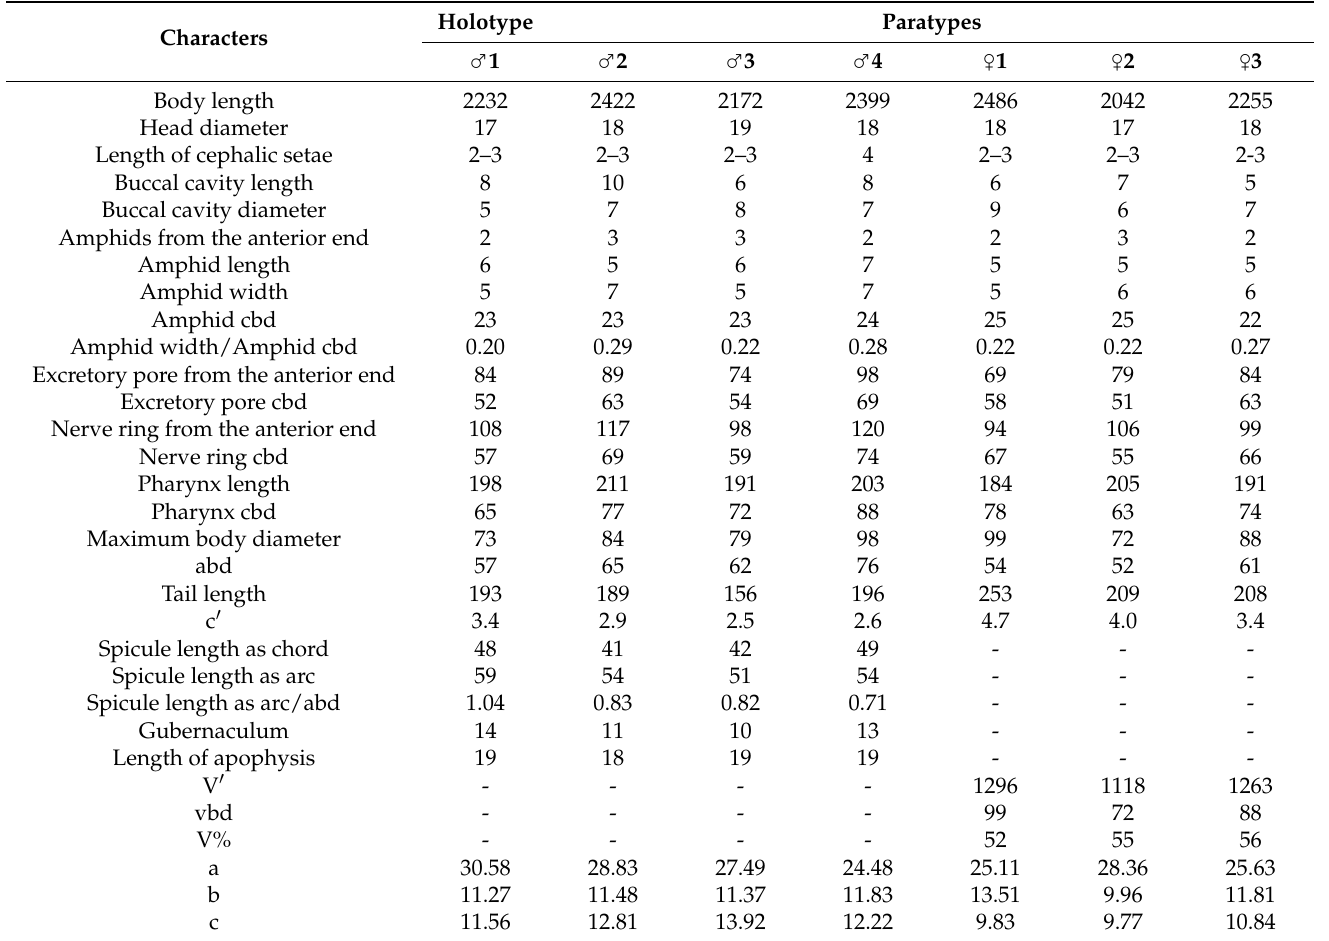
Table 2. Morphometrics of Anticyathus shenzhensis sp.nov. (in µ